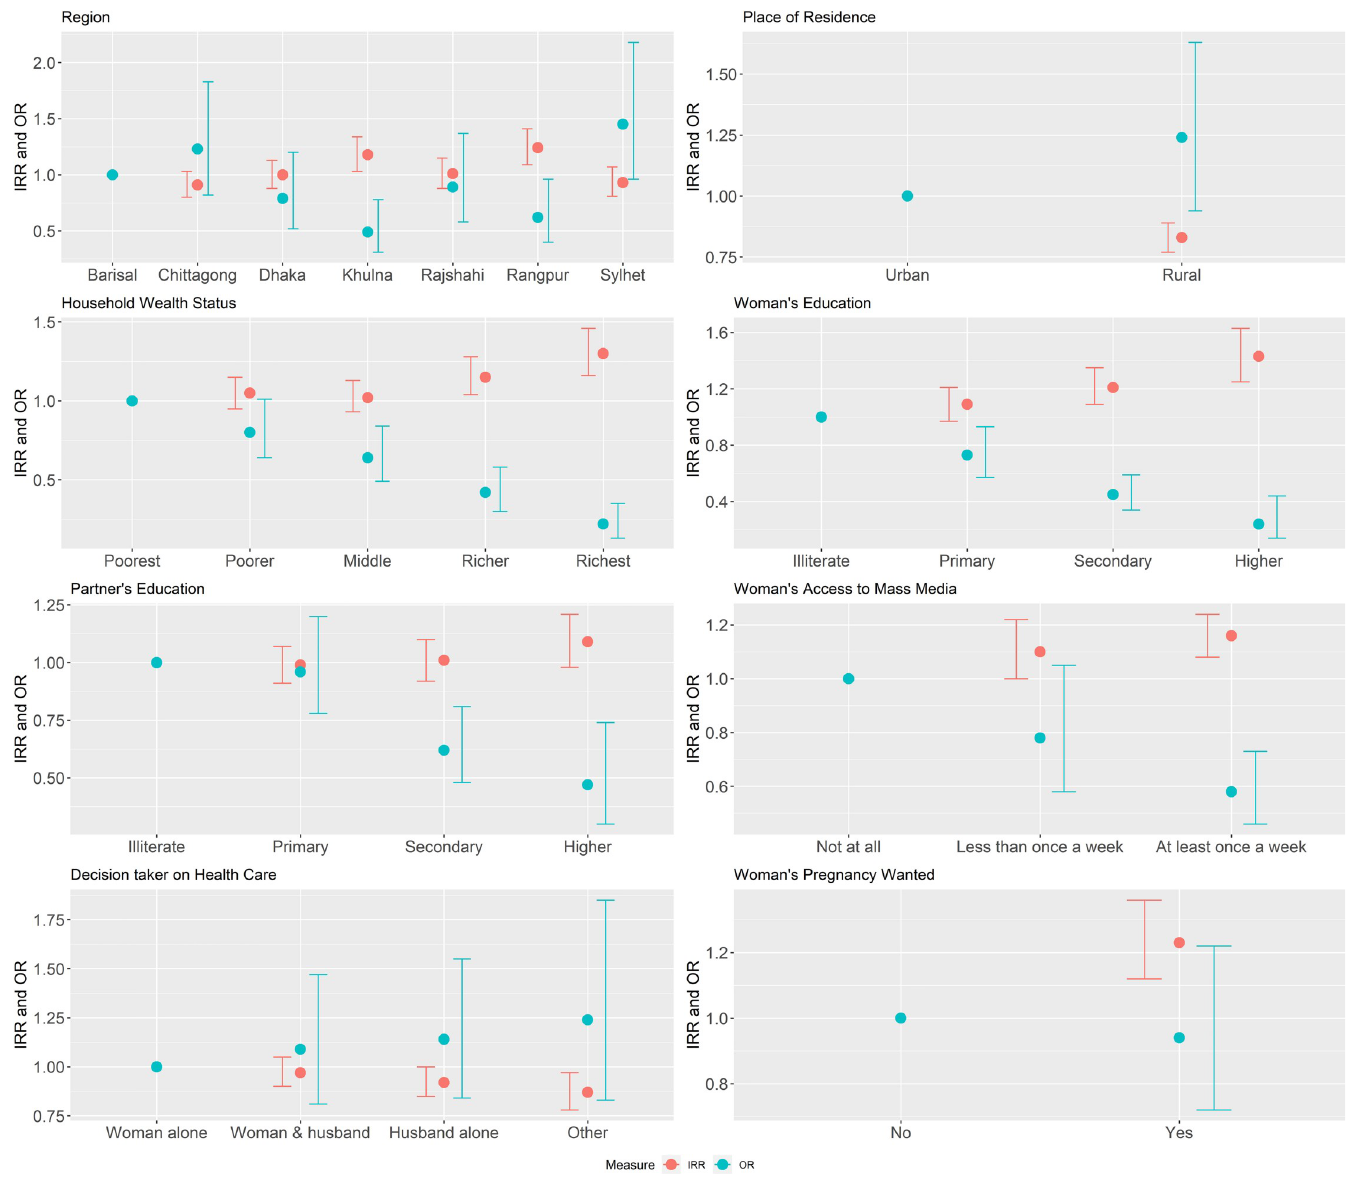
Fig 3. Estimated incidence rate ratio (IRR) of having ANC visits (red dot and confidence line) and odds ratio (OR) of not attending any ANC visit (blue dot and confidence line) with 95% confidence interval (CI) from the hurdle negative binomial regression with random intercept at both count- and zero-part (MHNBR. ERE)